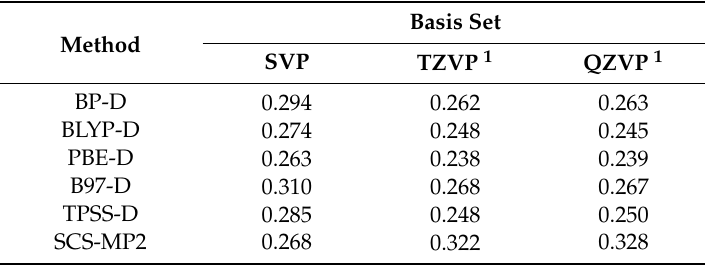
Table 3. RMSD (in Å) in atomic positions for the optimized isolated Fc 2 CS molecule relative to the reference molecular geometry extracted from the XRD crystal structure of Fc 2